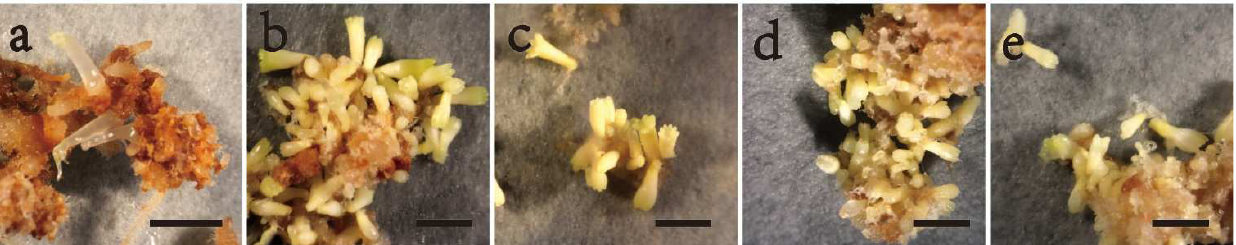
Figure 6. Mature somatic embryos of clone line 2–23 in Picea pungens SE under various ABA con- centrations: ( a ) 0 mg/L; ( b ) 10 mg/L; ( c ) 20 mg/L; ( d ) 30 mg/L; and ( e ) 40 mg/L. Bars: ( a – e ) = 0.5 cm.